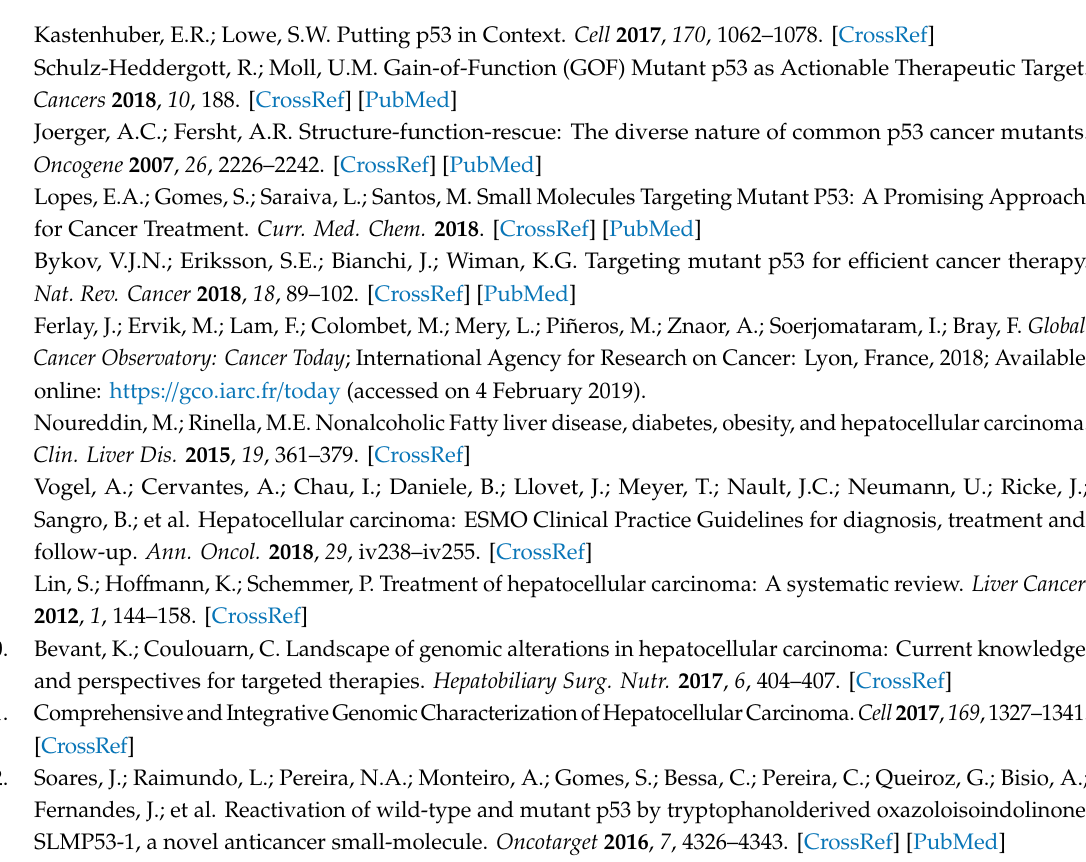
data of SLMP53-2 in Wistar rats, Table S5: List of antibodies used in western blot (WB), immunofluorescence (IF), immunohistochemistry, and immunoprecipitation, Table S6: List of primers, Table S7: Quantification of western